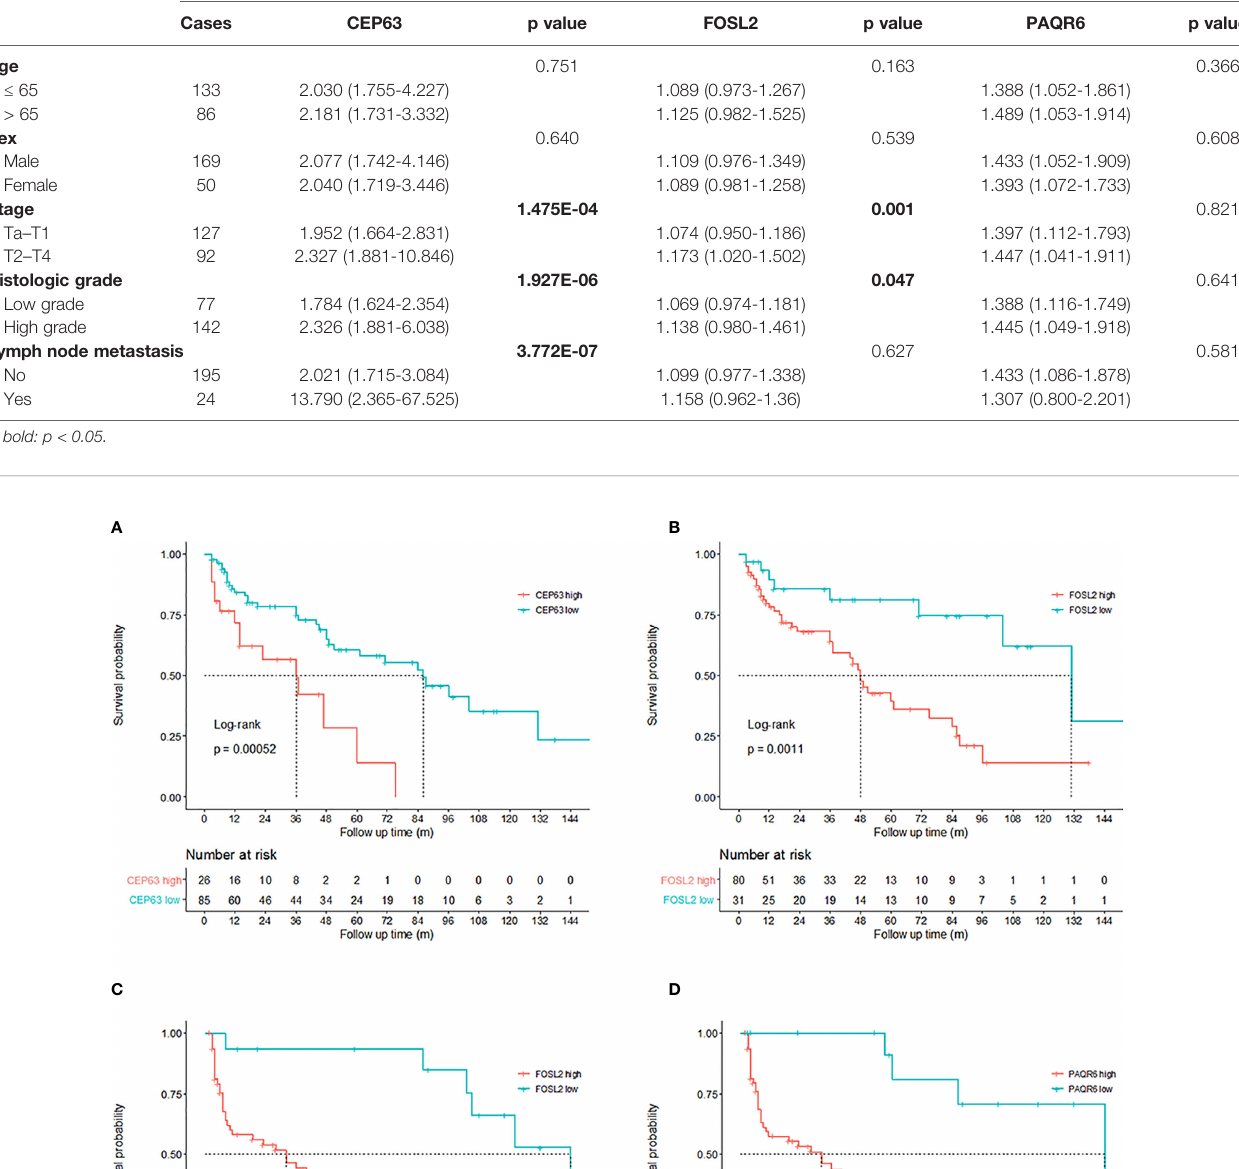
TABLE 4 | Correlation between 3 CNVs and clinicopathological characteristics of 219 BC patients [median (interquartile range)]. Parameters